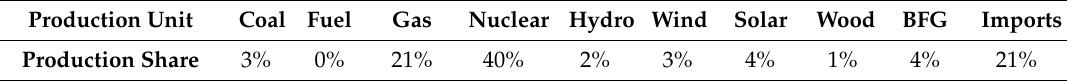
Table 11. Electricity generation in Belgium for 2014 per power plant type